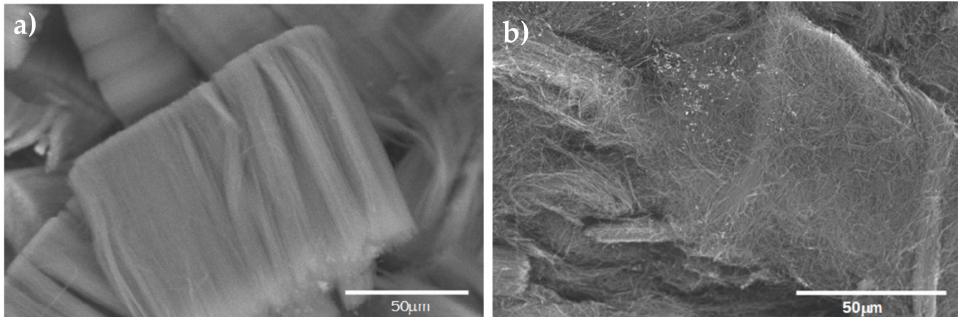
Figure 1. ( a ) CNx without purification, ( b ) CNx after treatment with acid for purification.